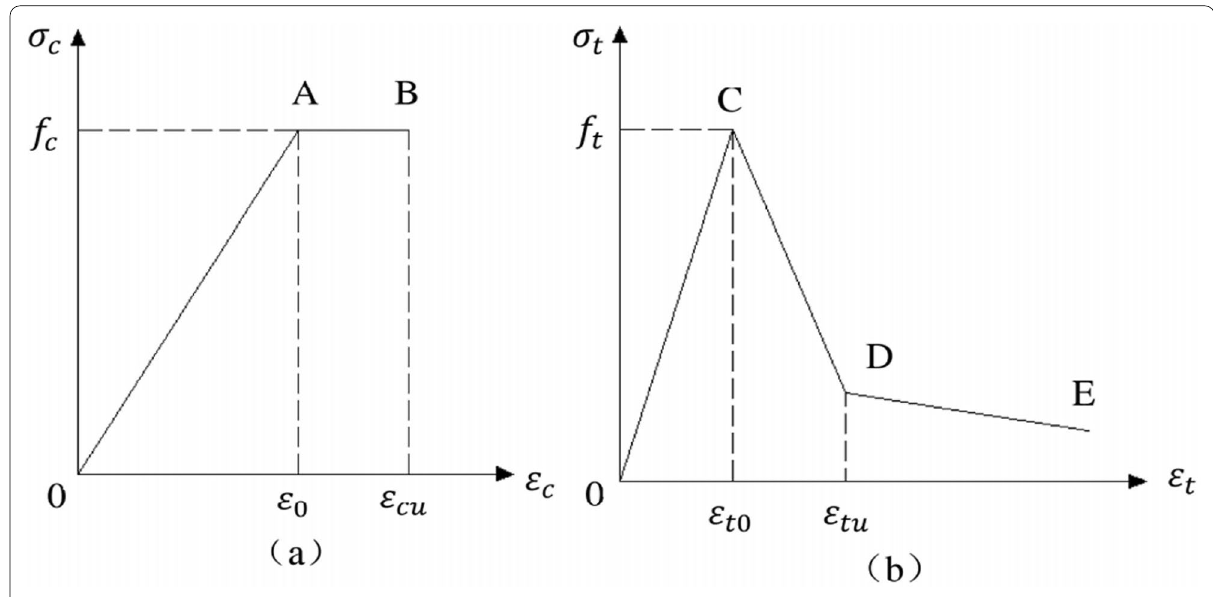
Fig. 12 Constitutive relation of autoclaved aerated